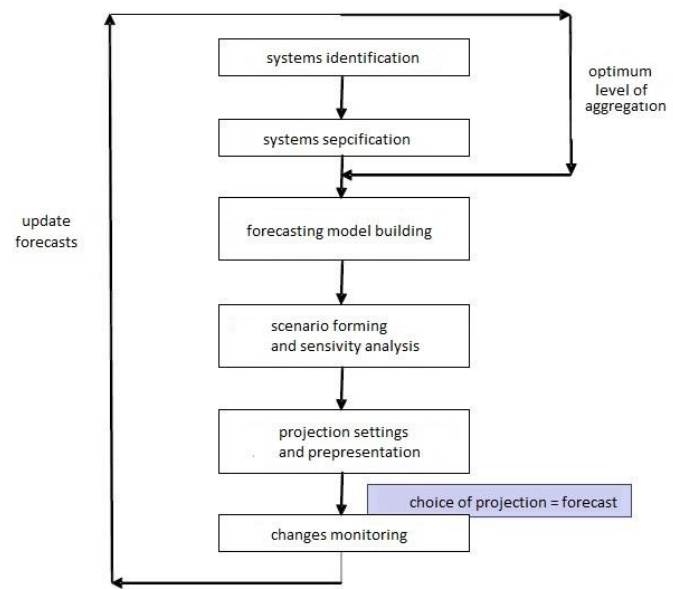
Figure 2. Flowchart of forecasting demographic. Source: [21].